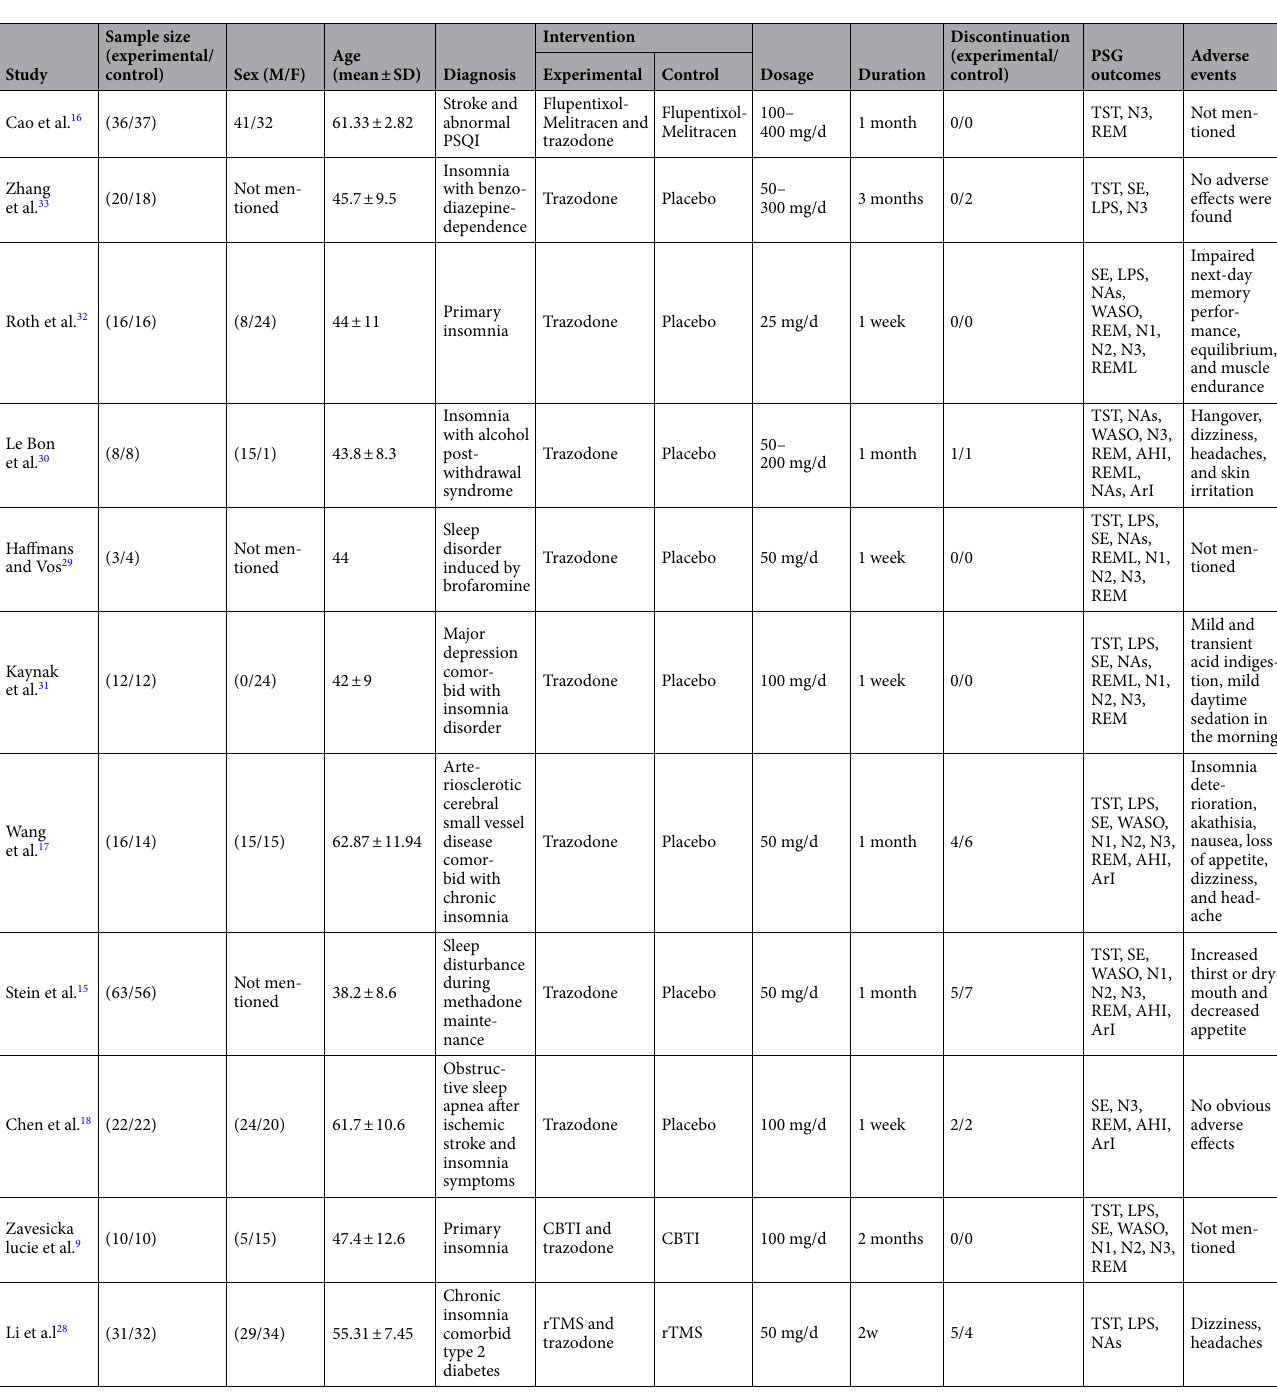
Table 1. Summary of the characteristics of the included studies. AHI apnea–hypopnea index, ArI arousal index, CBTI cognitive behavior therapy for insomnia, F female, LPS latency to onset of persistent sleep,